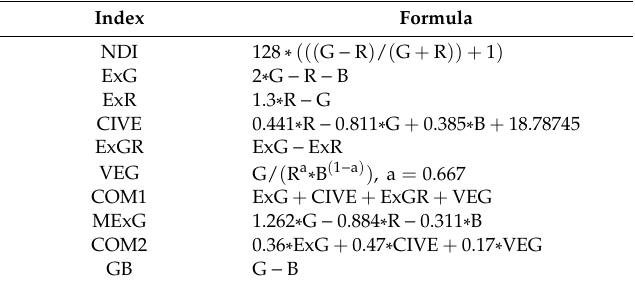
Table 4. Colour vegetation indices formulas.